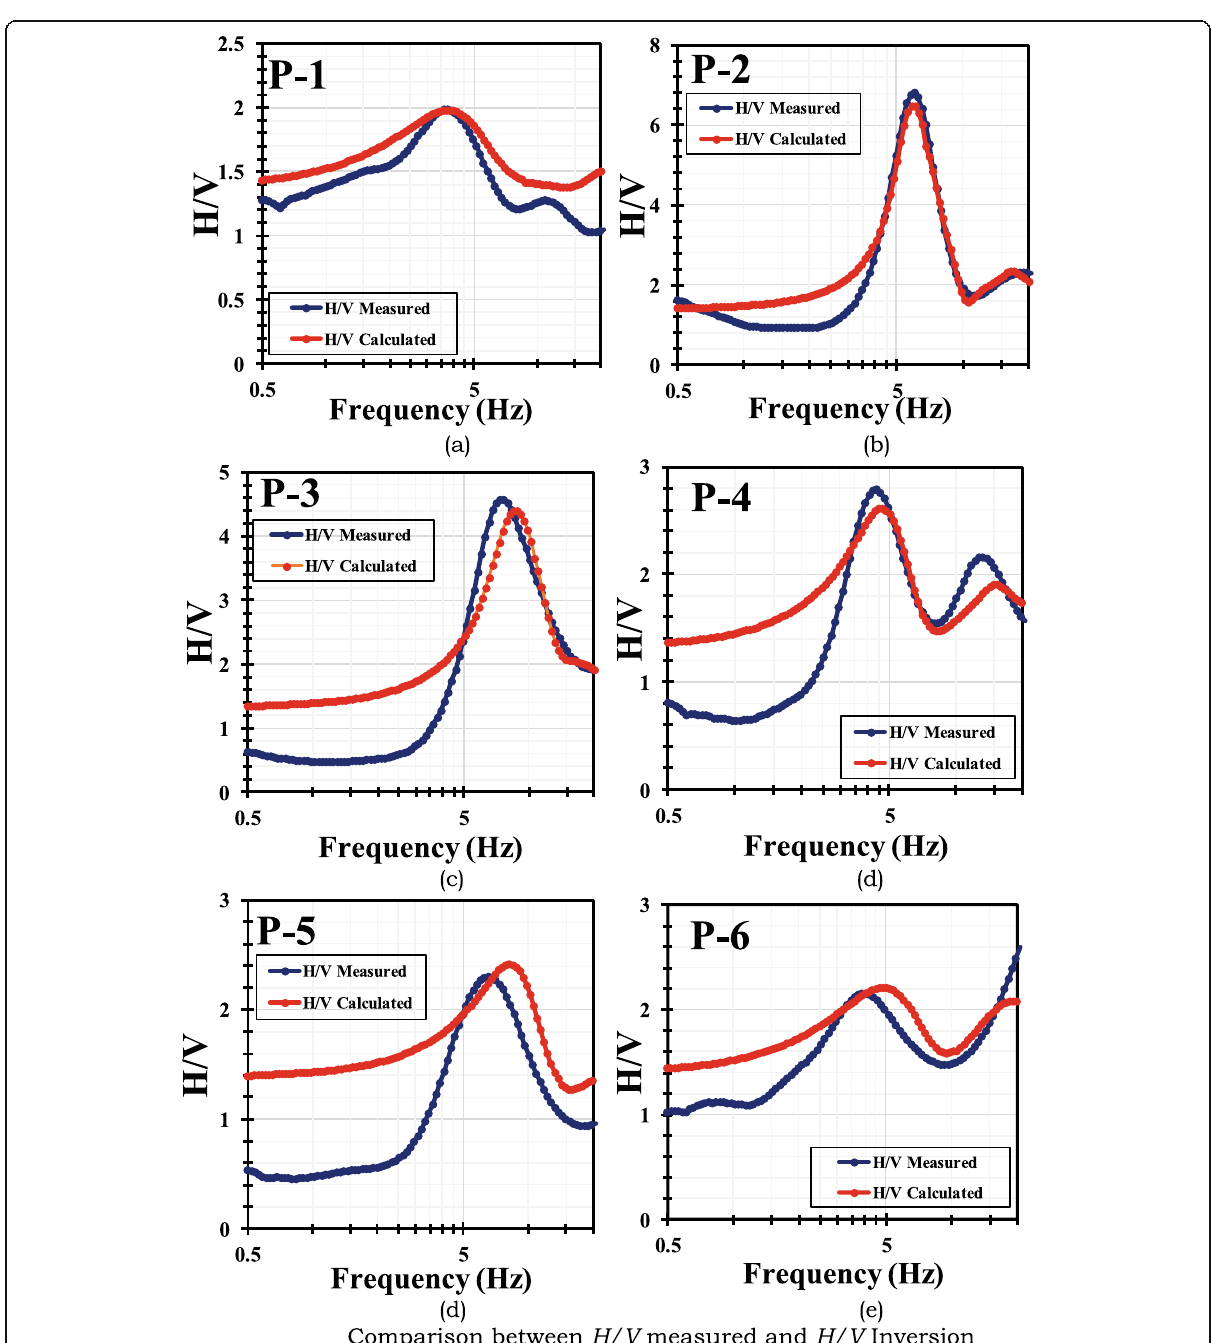
Fig. 8 Comparison between H/V measured and H/V